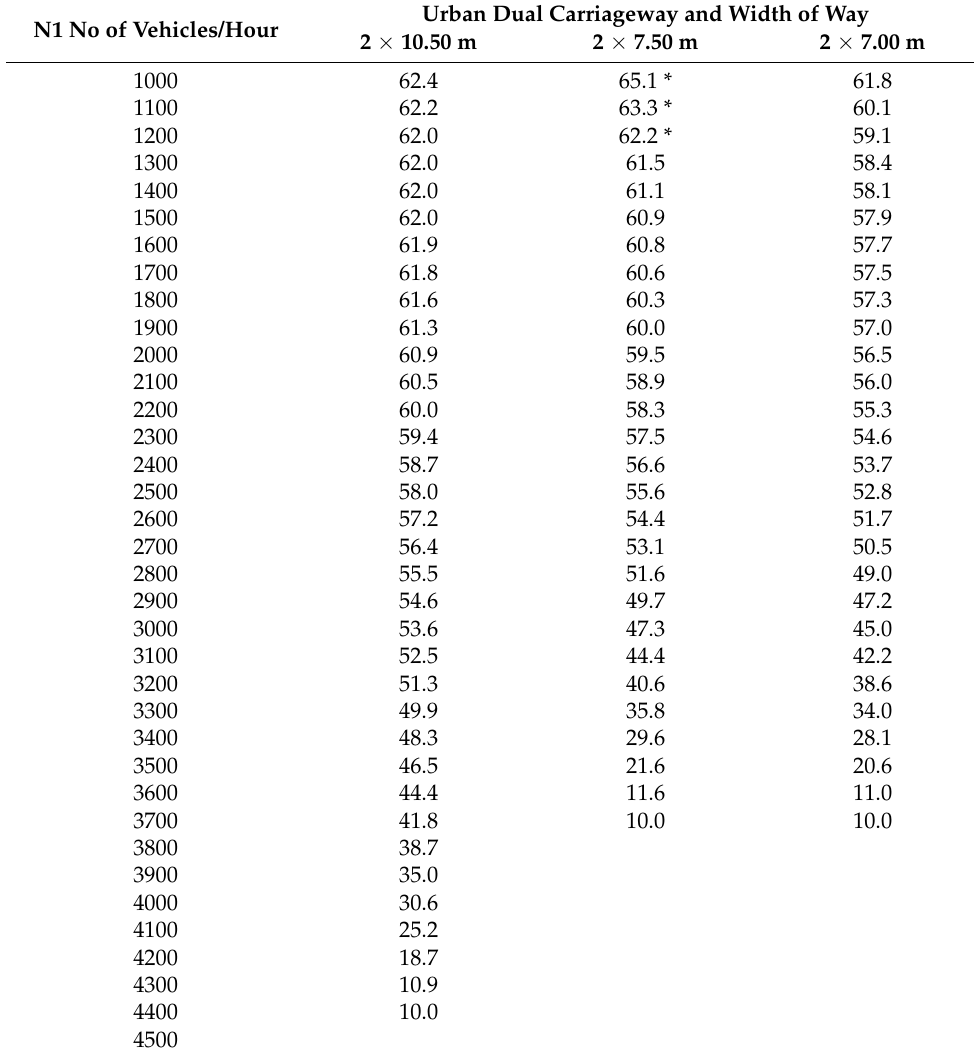
Table A1. Vehicle travel speed (km/h) on urban dual carriageways depending on vehicle traffic flow N1 (vehicles/hour).